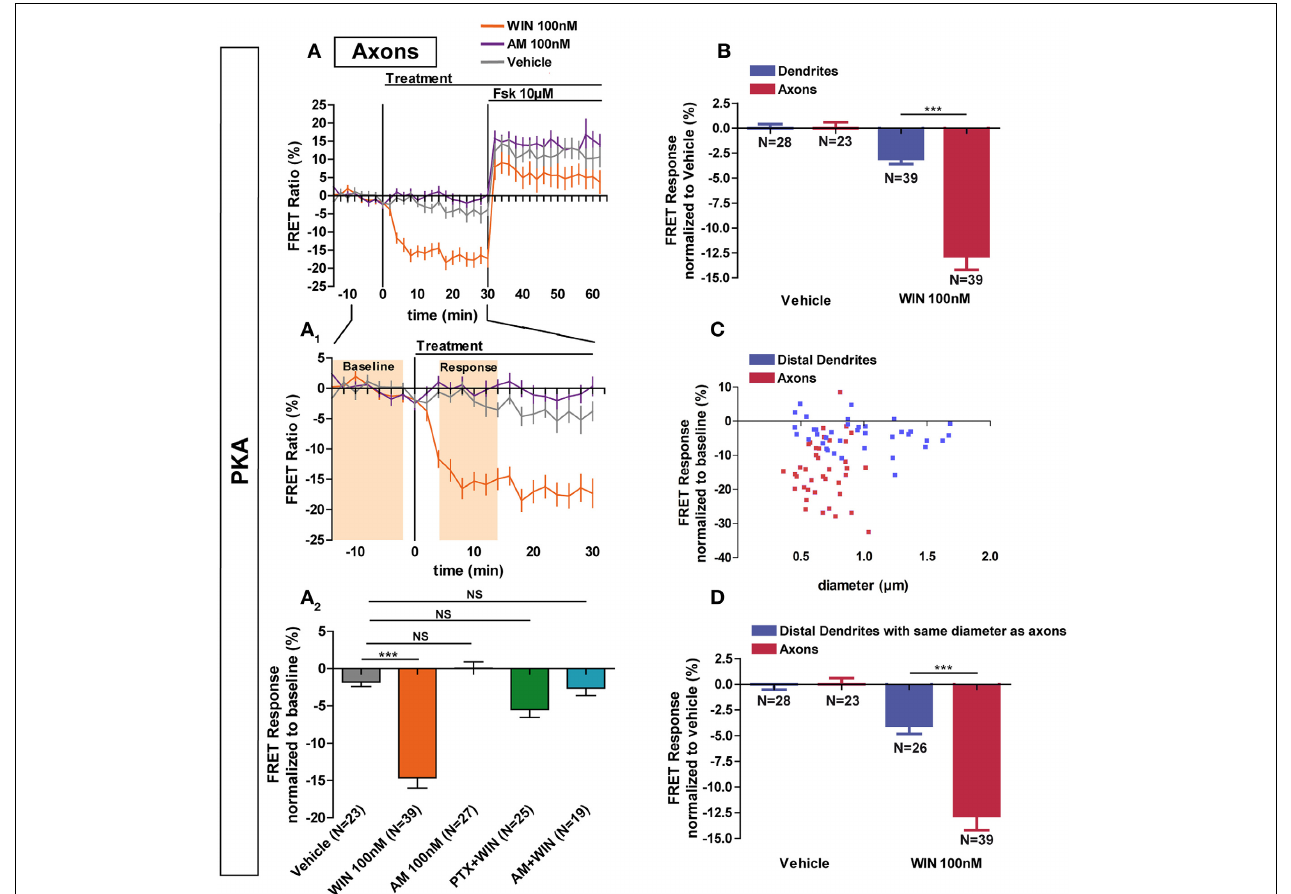
FIGURE 3 | Axonal CB1R signaling differs from dendritic signaling. (A) Averaged axonal responses of AKAR4-Kras expressing neurons, as shown on Figures 1E,F . The FRET ratio normalized to baseline was calculated for each neuron with a time-resolution of 2min. The curves represent mean ± S.E.M. of the FRET ratio for all imaged neurons at each time point. Addition of agonist WIN 100nM but not of vehicle or inverse-agonist AM281 100nM (AM) at t0 results in rapid high-amplitude FRET ratio decrease. At 30min, adenylyl-cyclase activator Forskolin (Fsk) was added at 10 μ M, inducing a saturating increase of the FRET ratio. A 1 : Zoom between − t14 and t30 of A shows significant modulation of basal PKA activity after activation of CB1Rs. A2: FRET responses were calculated as the mean response between t4 and t14min (shaded zone labeled “Response” on A 1 ), using data normalized to the baseline (shaded zone between − t14 and − t2, labeled “Baseline” on A 1 ). Implication of G i / o -proteins was shown by the specific inhibitor pertussis